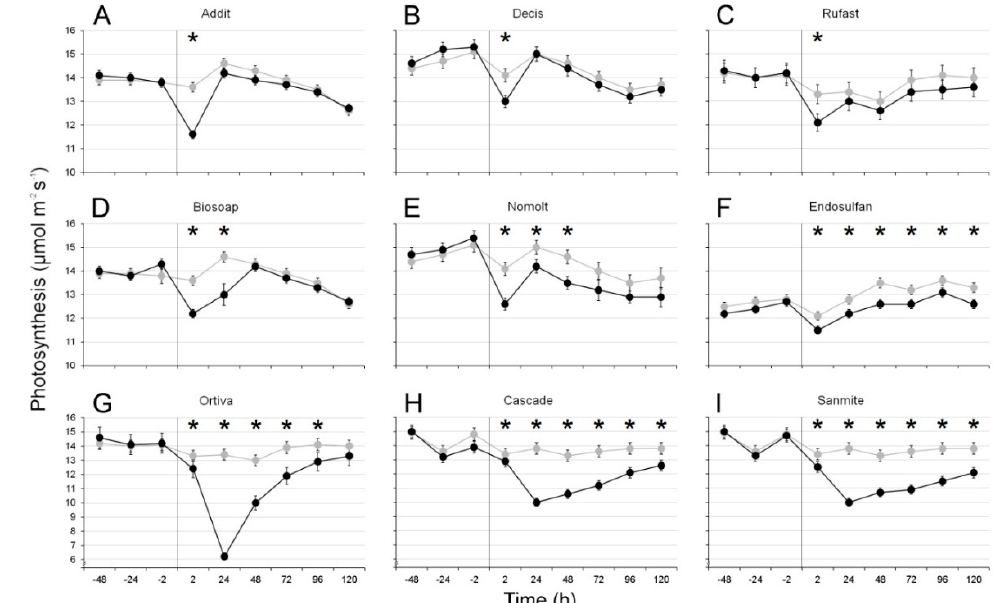
Figure 1. Mean ± SE photosynthetic rates ( µ moL CO 2 m − 2 s − 1 ) of sweet pepper leaves before and after treatment with nine different pesticides. Gray curves refer to control plants; black curves indicate treated plants. The moment when each treatment was conducted is indicated by a vertical line (i.e., time = 0). * Indicates significant differences ( p < 0.05) between treatments at a given time.